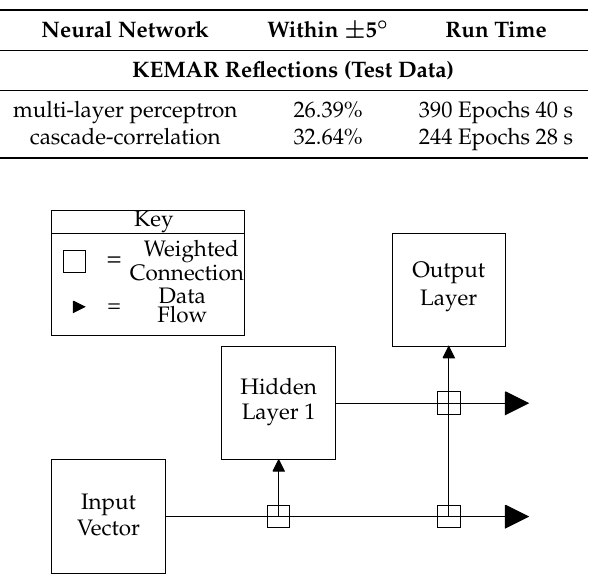
Figure 3. Cascade-correlation neural network topology used, where triangles signify the data flow and squares are weighted connections between the hidden layers and the incoming